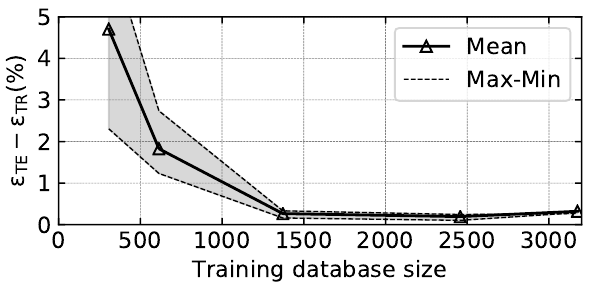
Figure 3. Training database independence study.